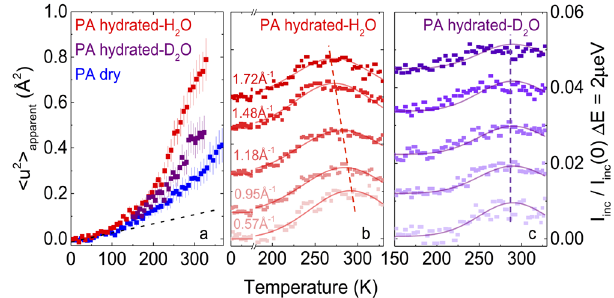
Fig. 1 Mean-square displacement and IFWS of dry and hydrated PA membranes. a Temperature dependence of the apparent mean-square displacement h u 2 i apparent for dry PA (blue), vapor hydrated in D 2 O (purple) and H 2 O (red); the dashed line indicates the mean-square displacement, obtained from the Debye – Waller factor. The error bars correspond to the maximum intervals in the low- Q extrapolation. b Inelastic fi xed window scan (IFWS) for PA hydrated in H 2 O and ( c ) hydrated in D 2 O, at representative Q -values; the pro fi les were vertically shifted for clarity and lines are guides to the eye. Source data fi